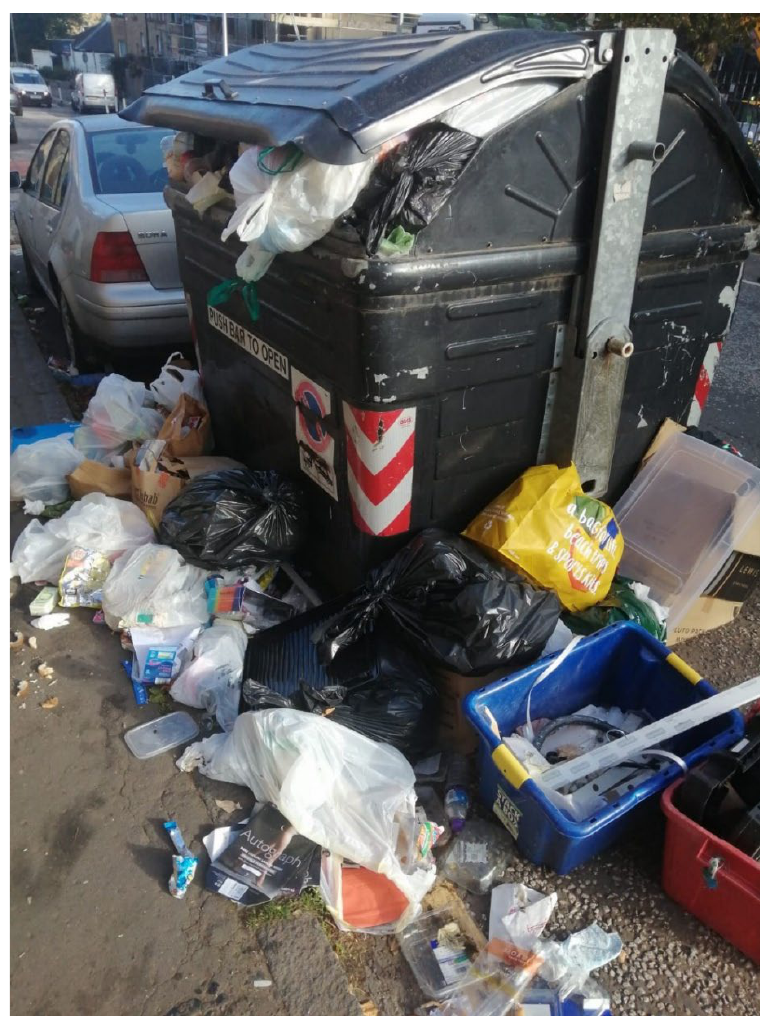
Figure 1 . An overflowing dustbin during Edinburgh waste workers’ strike, 31 August 2022. Image by Kaveri Qureshi, reproduced with